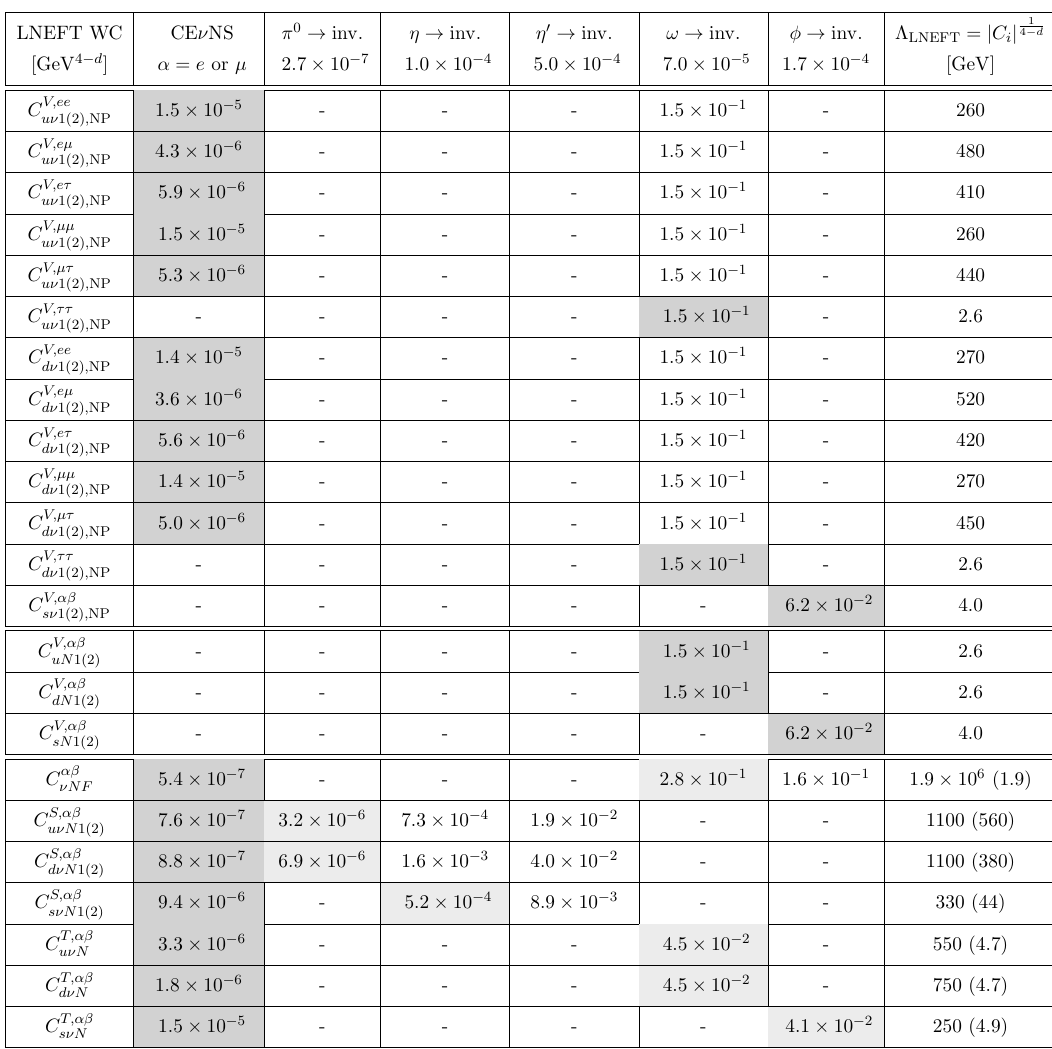
Table 3 . Constraints on the Wilson coe(cid:14)cients of the LNC operators in the LNEFT. The neutrino (cid:13)avors for the vector type operators C V are displayed explicitly. For CE (cid:23) NS the initial u ( d ) (cid:23) 1(2) neutrino (cid:13)avor is (cid:11) = e; (cid:22) . In other cases the neutrino (cid:13)avors (cid:11); (cid:12) are arbitrary. The gray cell displays the strongest constraint for each WC. In the last column we also show the e(cid:11)ective scale derived from the strongest constraint for each WC. Note that in the last sector, the gray and light gray cells are for (cid:11) = e; (cid:22) and (cid:11) = (cid:28) (cid:13)avors respectively. For the (cid:11) = (cid:28) case, the e(cid:11)ective scale is shown in parentheses (. . . ) in the last